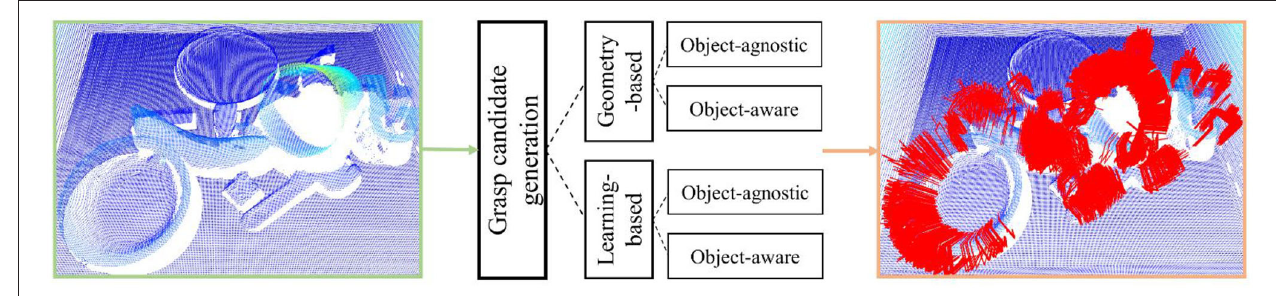
FIGURE 3 | The general pipeline of grasp candidate